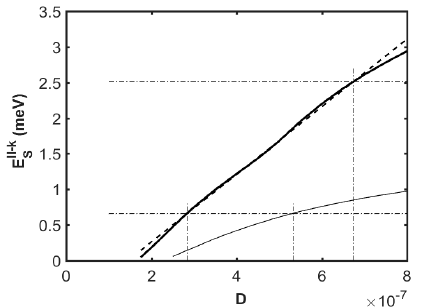
Figure 5. Binding energy E sll-k of the screened impurity state as a function of the oxide thickness D with the n s / T | a ≈ 6.6x10 7 cm − 2 / 0 K parameter (bold line) and n s / T | b ≈ 6.6x10 8 cm − 2 / 0 K parameter (thin line) for the InSb/SiO 2 /metal (ll- κ type) multi-layer quantum structure.